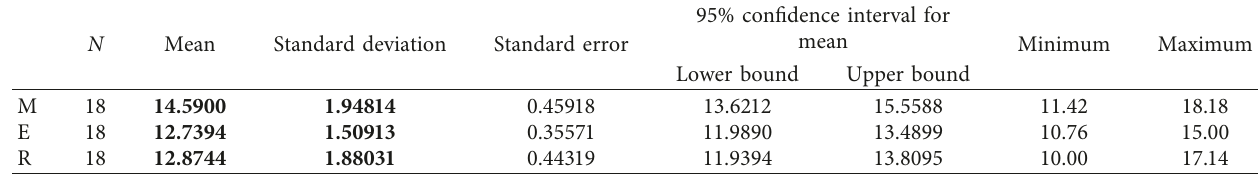
Table 8: Descriptive statistics for the learners’ scores in the delayed posttest.